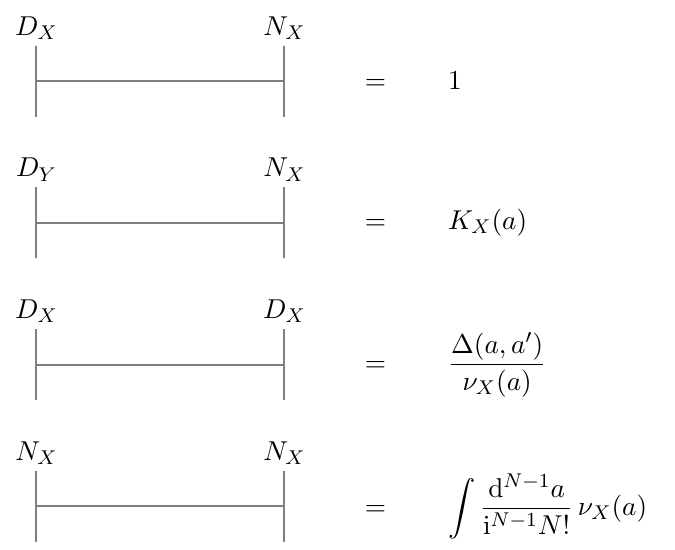
Figure 7 . A sampling of the correlation functions of Neumann and Dirichlet boundary conditions. There is an isomorphic set of functions obtained by interchanging X